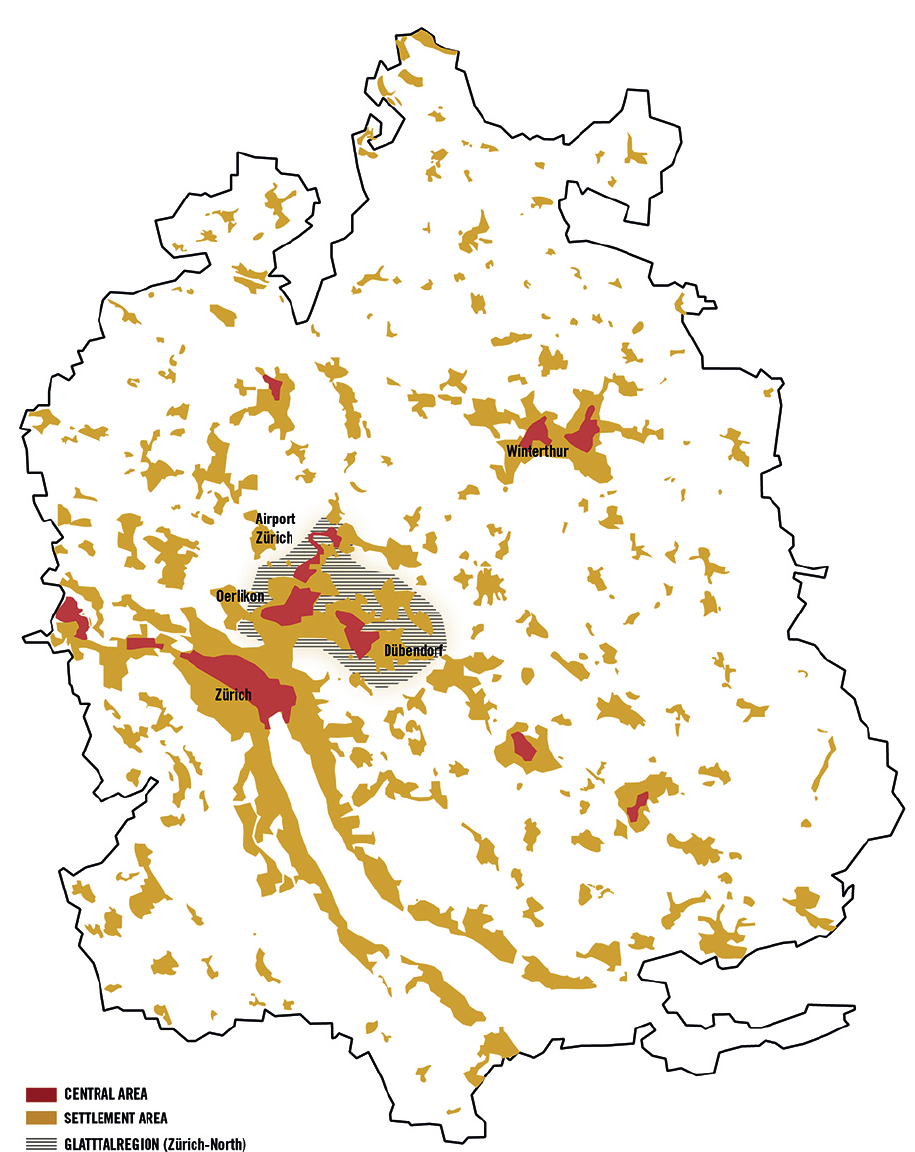
Figure 1. Overview of the settlement structure and central areas in the Zürich metropolitan area and the location of Zürich- Nord/Glattal area. Source: author based on Canton Zürich,